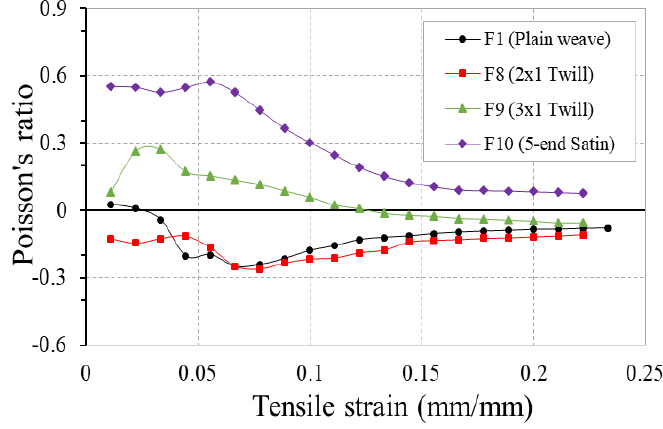
Figure 19. PR-tensile strain curves of fabrics F1, F8, F9 and F10 made of different weave structures.